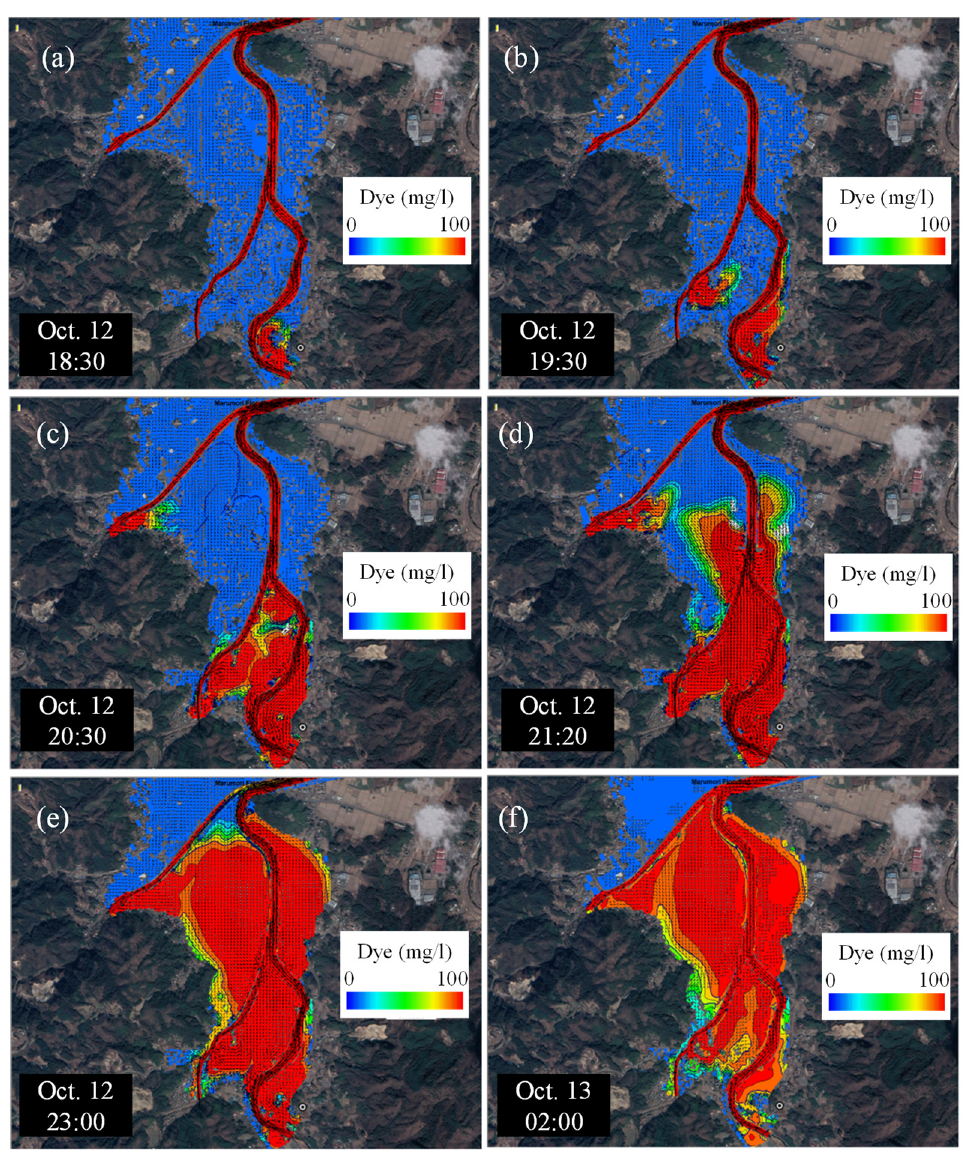
Figure 15. Simulation results of the river overflow and flood propagation in the Marumori area; where (a–f) are the model snapshots at different times.